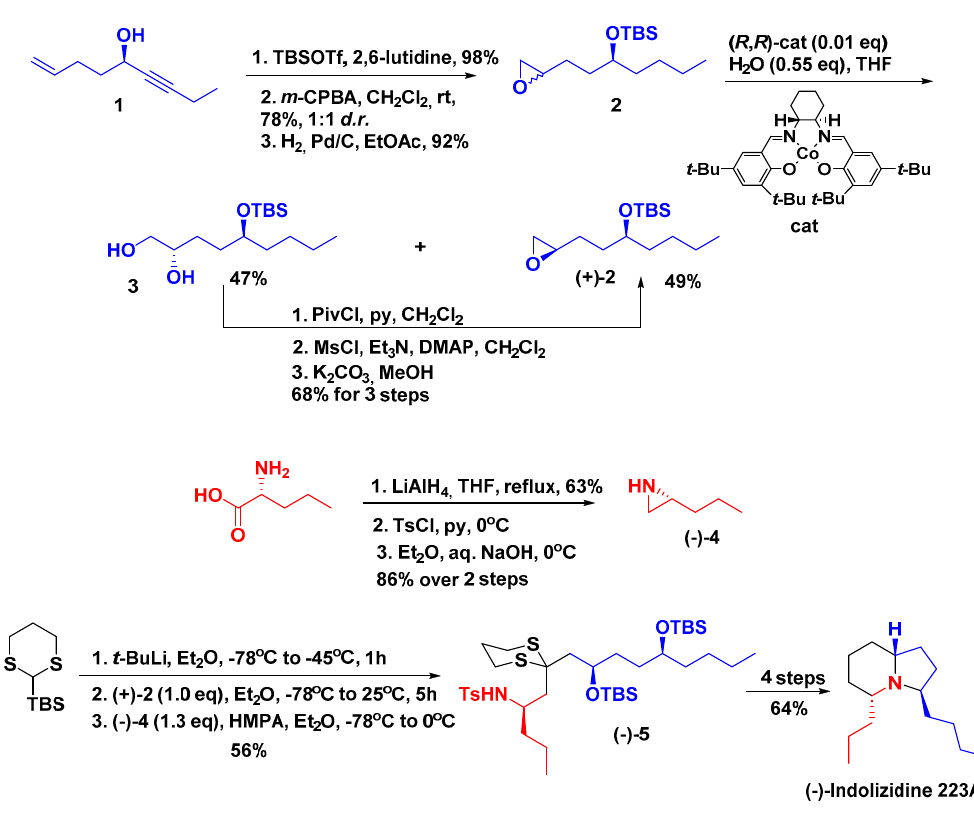
Scheme 1. Total synthesis of ( − ) ‐ indolizidine